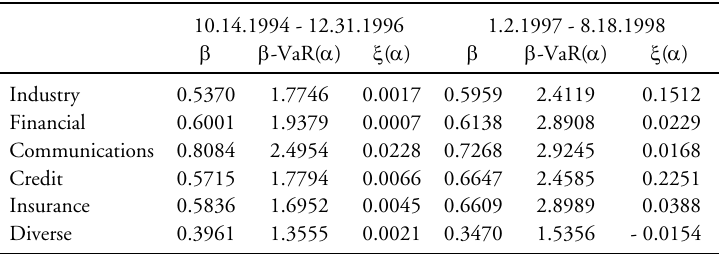
Measures of market risk in two subperiods.